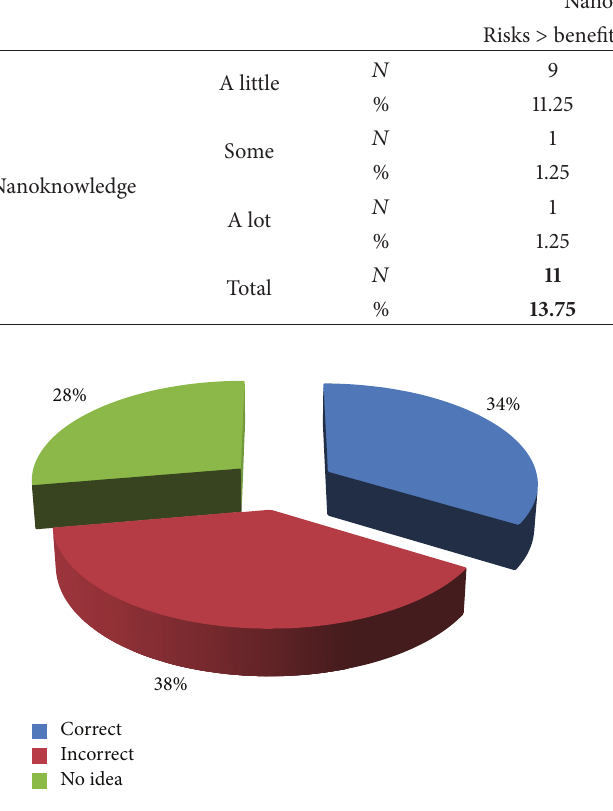
Figure 2: Responses on nanomedicine